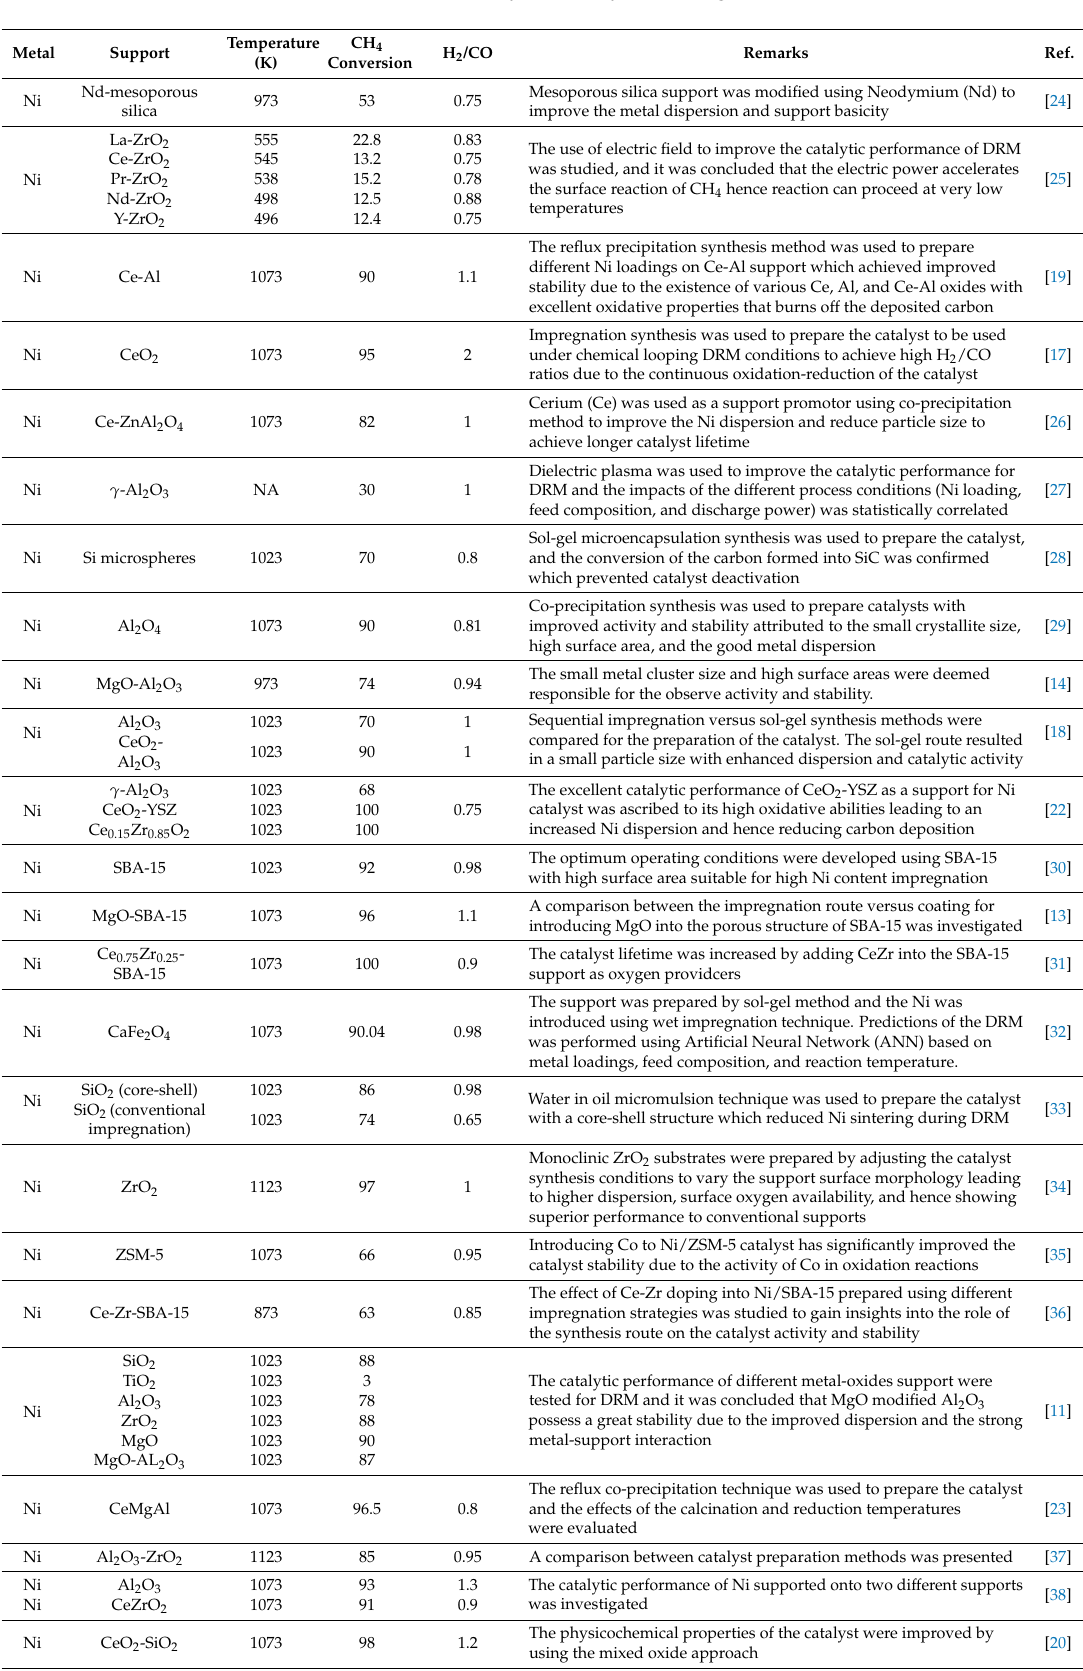
Table 1. Ni-based metal-oxide catalysts for dry reforming of methane